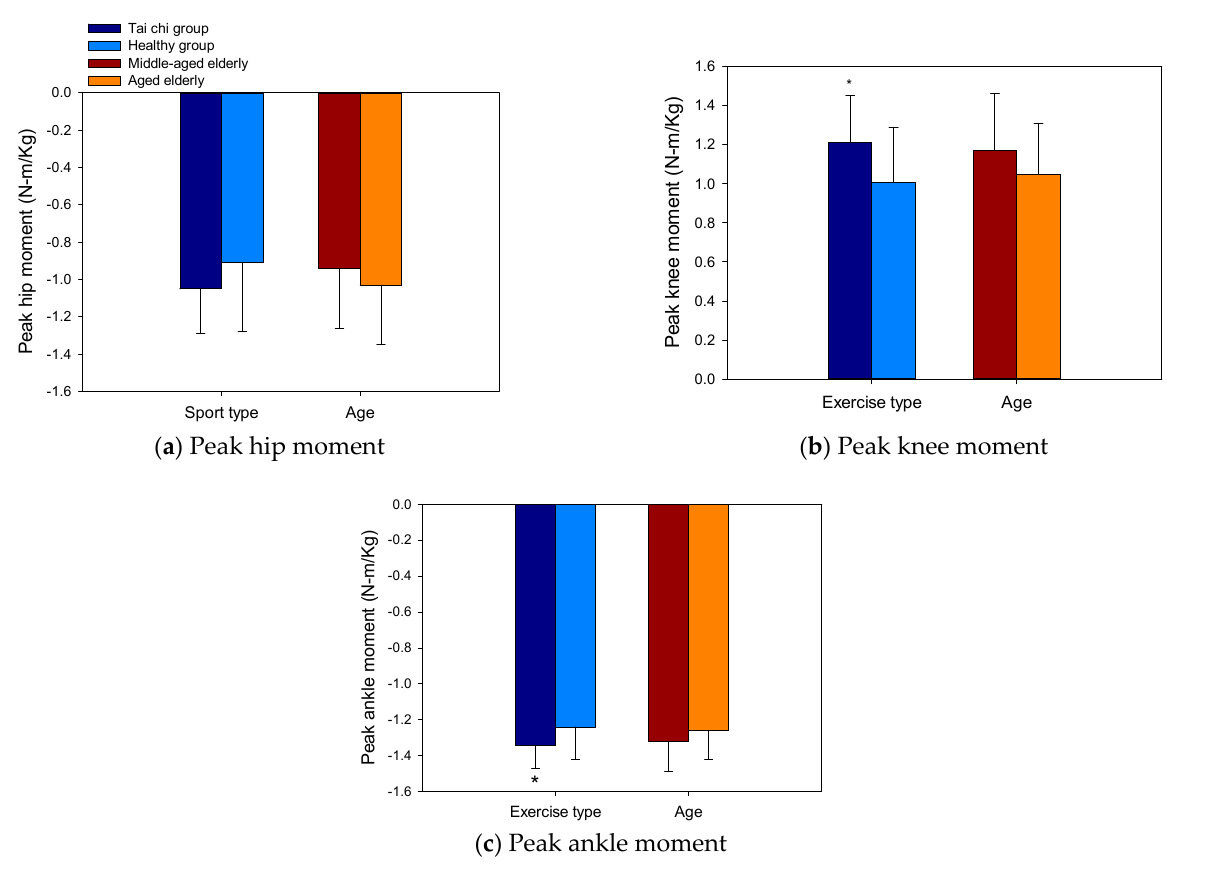
Figure 2. Peak hip, knee and ankle moments. Note: * indicates a significant difference between age factor.